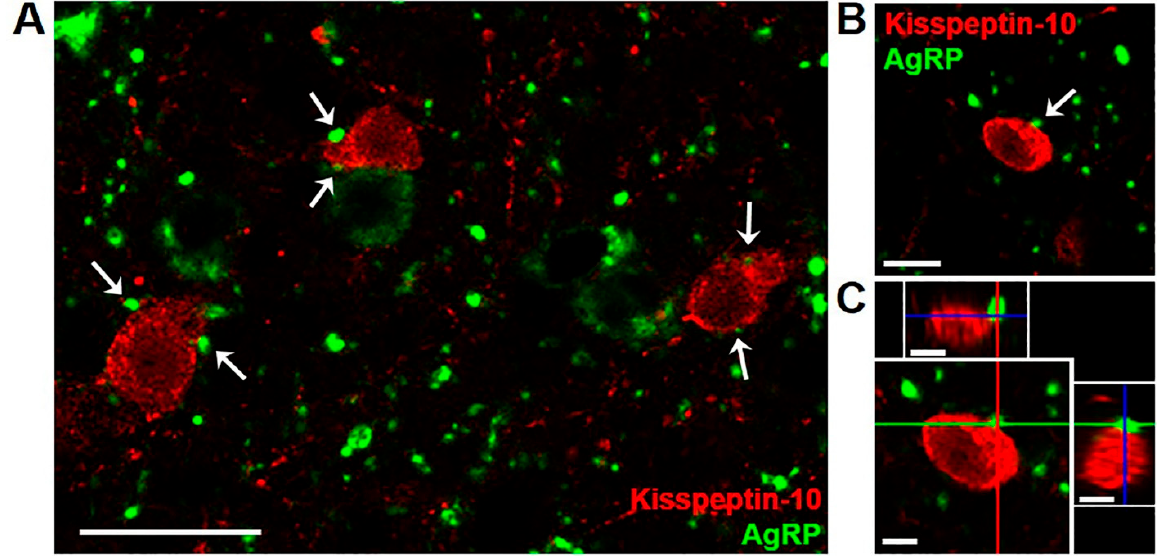
Figure 1. Confocal images (1.0 µ m optical section; 40 × magnification) showing dual-label immunofluorescence for AgRP (green) and kisspeptin (red) in the arcuate nucleus of a castrated male sheep (wether). White arrows ( A , B ) indicate examples of AgRP-immunoreactive (ir) terminals in apposition to arcuate kisspeptin neurons, with AgRP-ir cell bodies and fibers seen in the vicinity. Orthogonal views ( C ) confirm close contact of an AgRP-labeled bouton to a kisspeptin cell body. Red, green, and blue lines in ( C ) indicate X, Y, and Z planes, respectively. Scale bars = 25 µ m ( A ), 10 µ m ( B , C ).